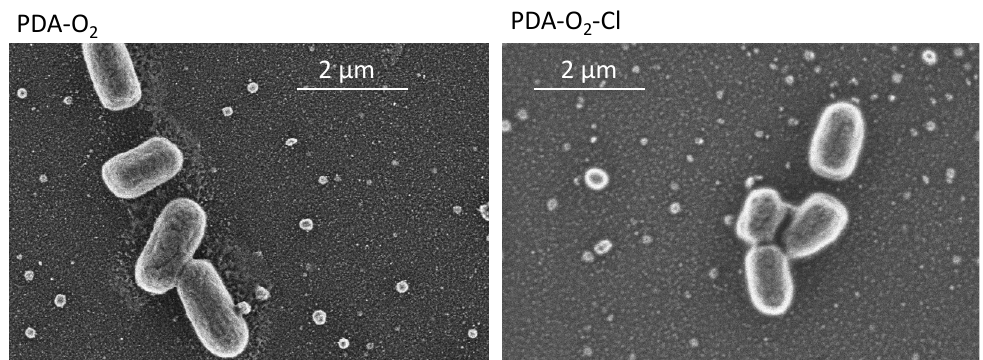
Figure 8. SEM micrographs of E. coli on PDA–O 2 ( left ) and PDA–O 2 –Cl ( right ) coatings.